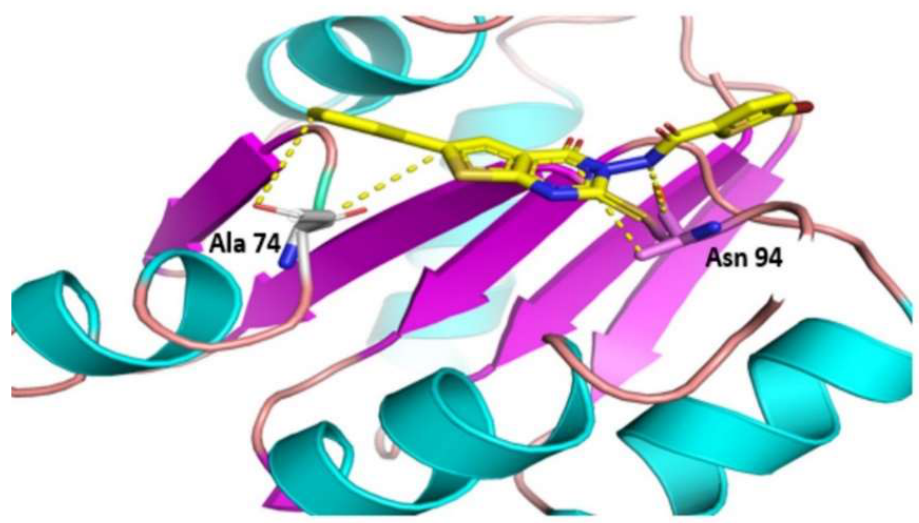
Figure 6. Hydrogen bond interaction of ZINC000020530348 with the drug target.